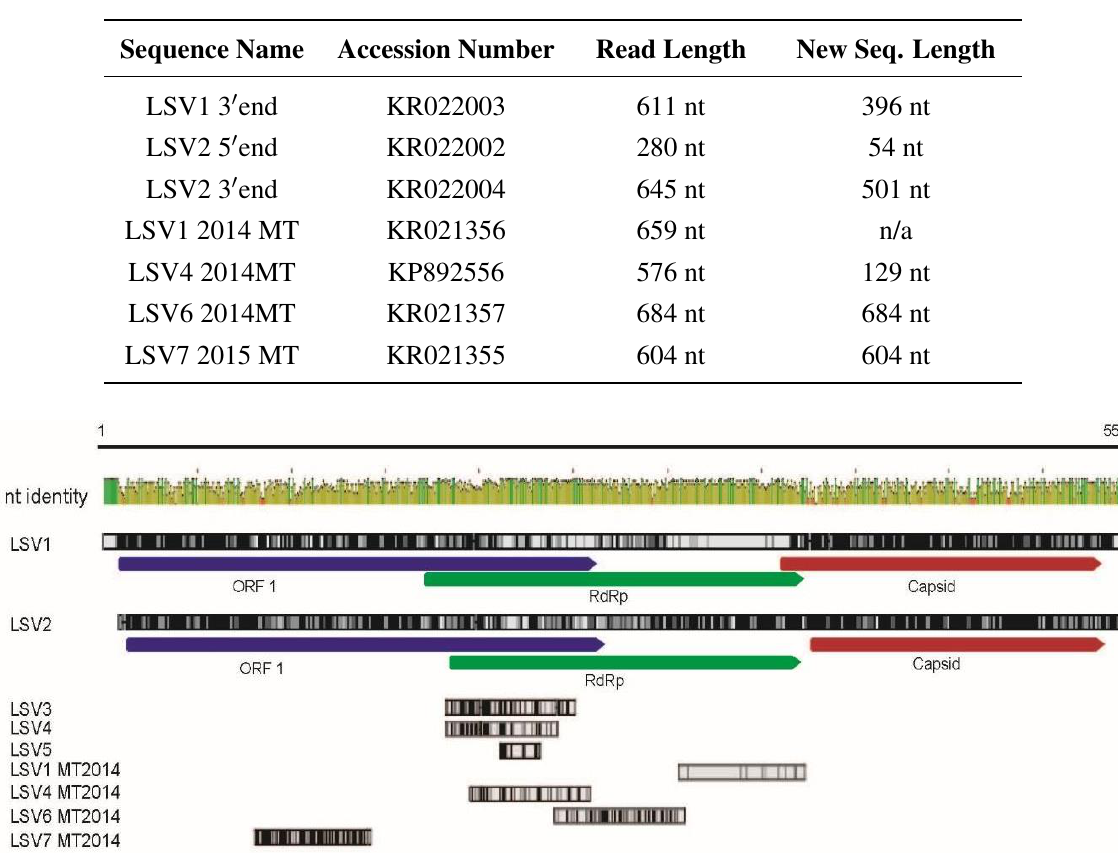
Figure 2. Lake Sinai viruses—genome comparison and LSV1 and LSV2 genomes extended. Lake Sinai virus nucleotide alignments using LSV1 (HQ871931) as the reference genome for numbering. The consensus sequence view, high peak height and green color represent maximum nucleotide identity of 100%, low peak height and red color indicate low nucleotide identity. Lake Sinai virus sequences (LSV1, Lake Sinai virus 1 (HQ871931); LSV2, Lake Sinai virus 2 (HQ888865); LSV3, Lake Sinai virus 3 (JQ480620); LSV4, Lake Sinai virus 4 (JX878492); LSV5, Lake Sinai virus 5 (KC880124), and 2014MT sequences: LSV1 (KR021356), LSV4 (KP892556), LSV6 (KR021357), and LSV7 (KR021355). Additional LSV sequences that were included in the Geneious nucleotide alignment using the default cost matrix (65% similarity (5.0/ − 4.0) [37]), but not depicted in this figure